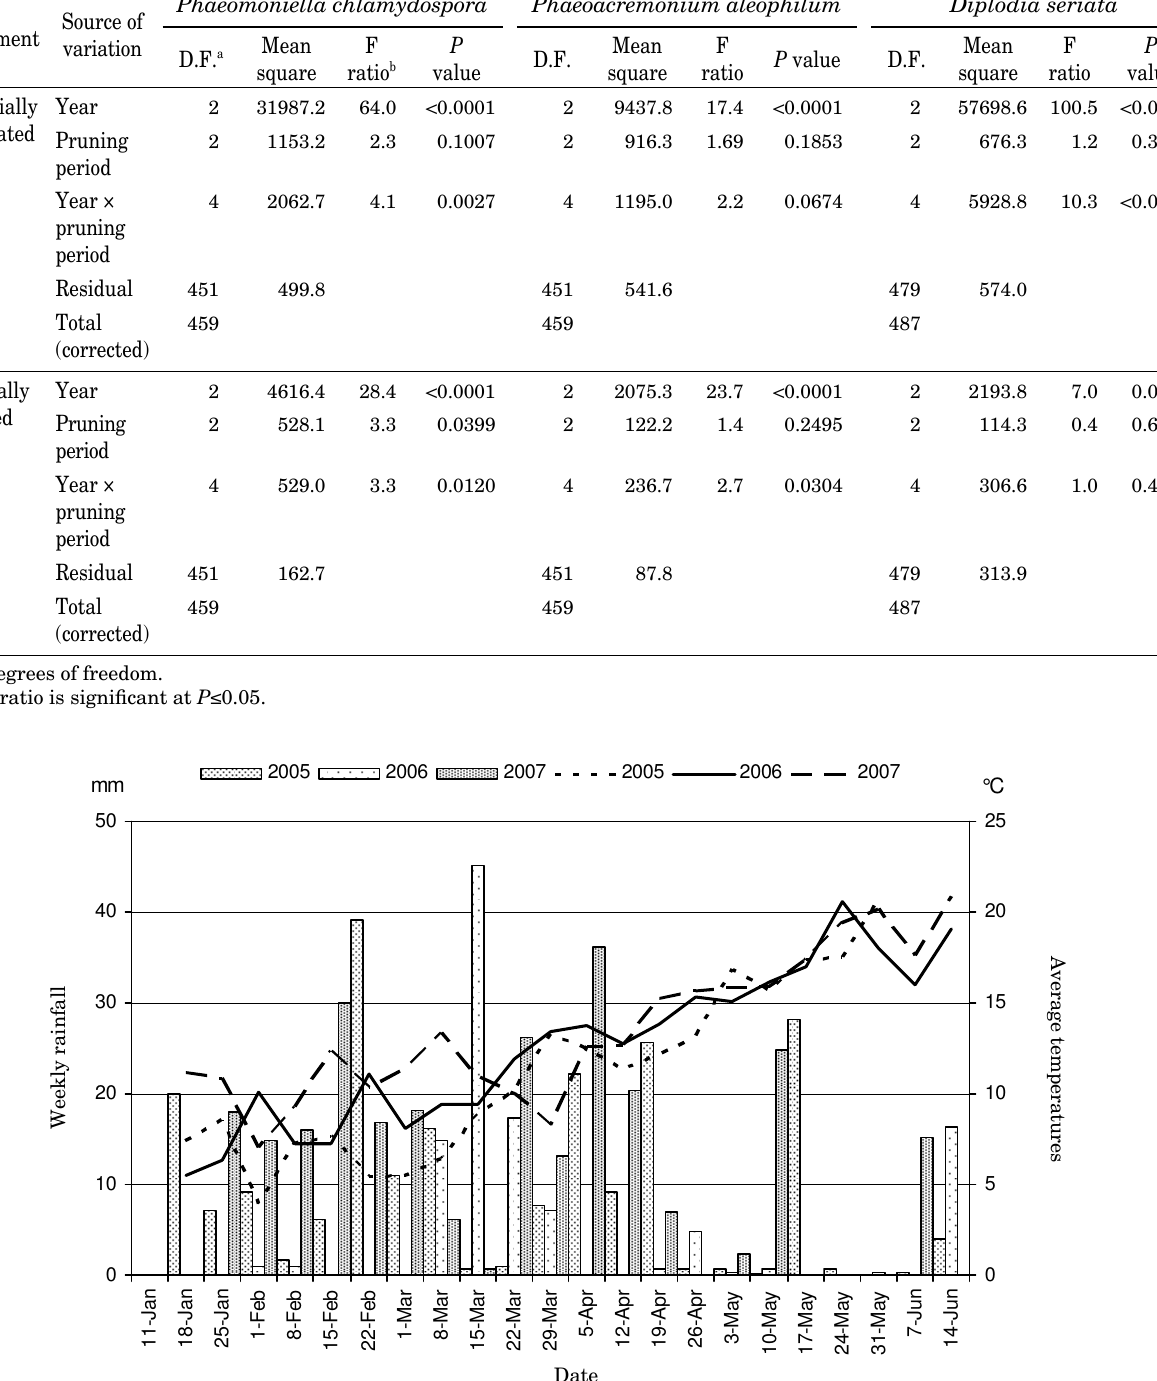
Fig. 1. Weekly rainfall (bars, mm) and average temperatures (lines, °C) recorded during the trials in the period